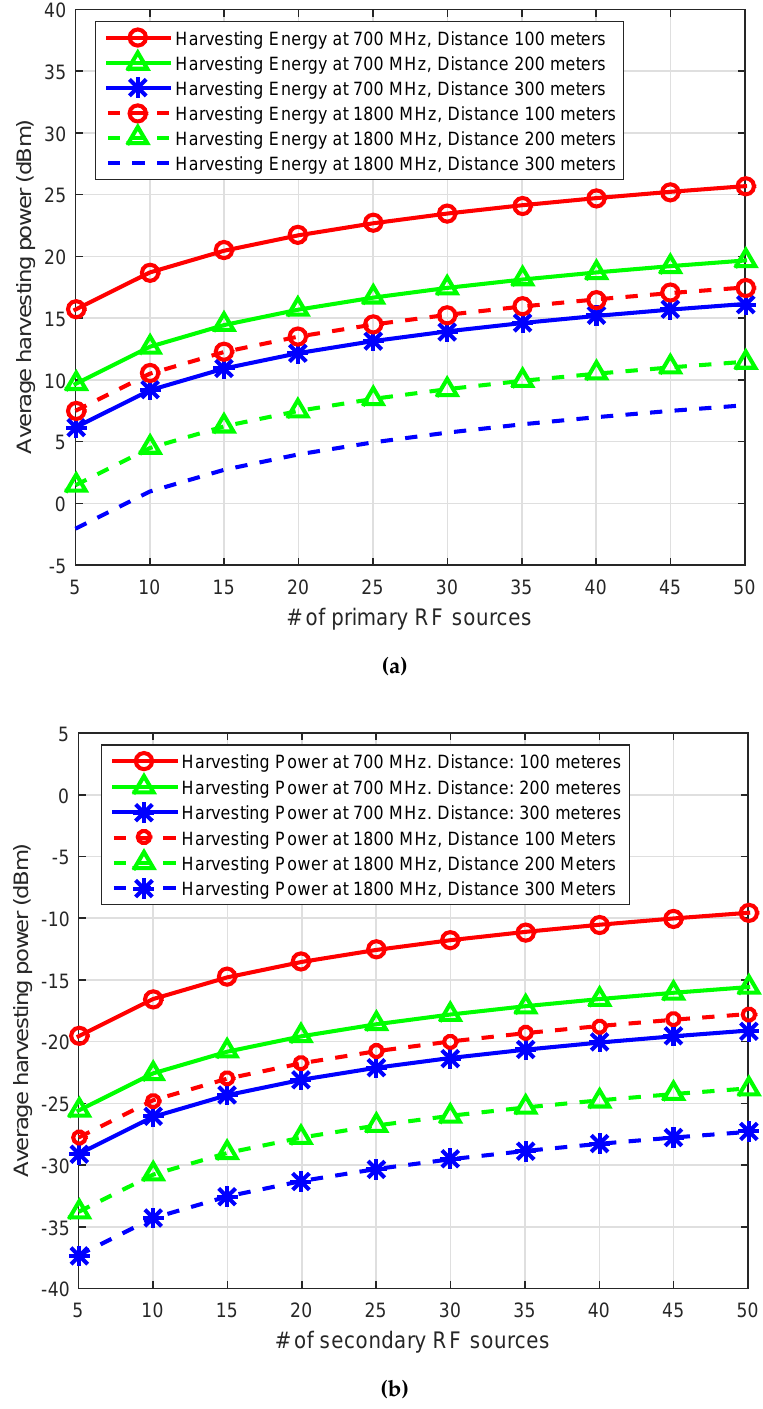
Figure 6. Received and harvesting power at receiver. ( a ) Same power and link gains of RF sources; ( b ) Different power and link gains of RF